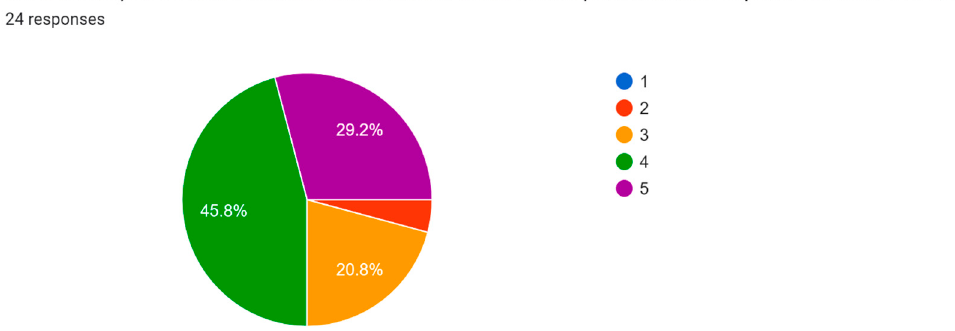
Figure 15. VoRtex test results from Google Forms report. User interaction experience inside VW.